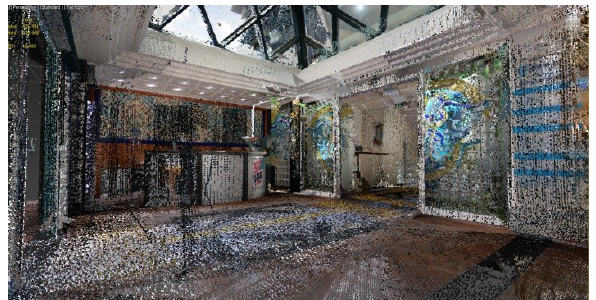
Figure 20: The points cloud of the indoor